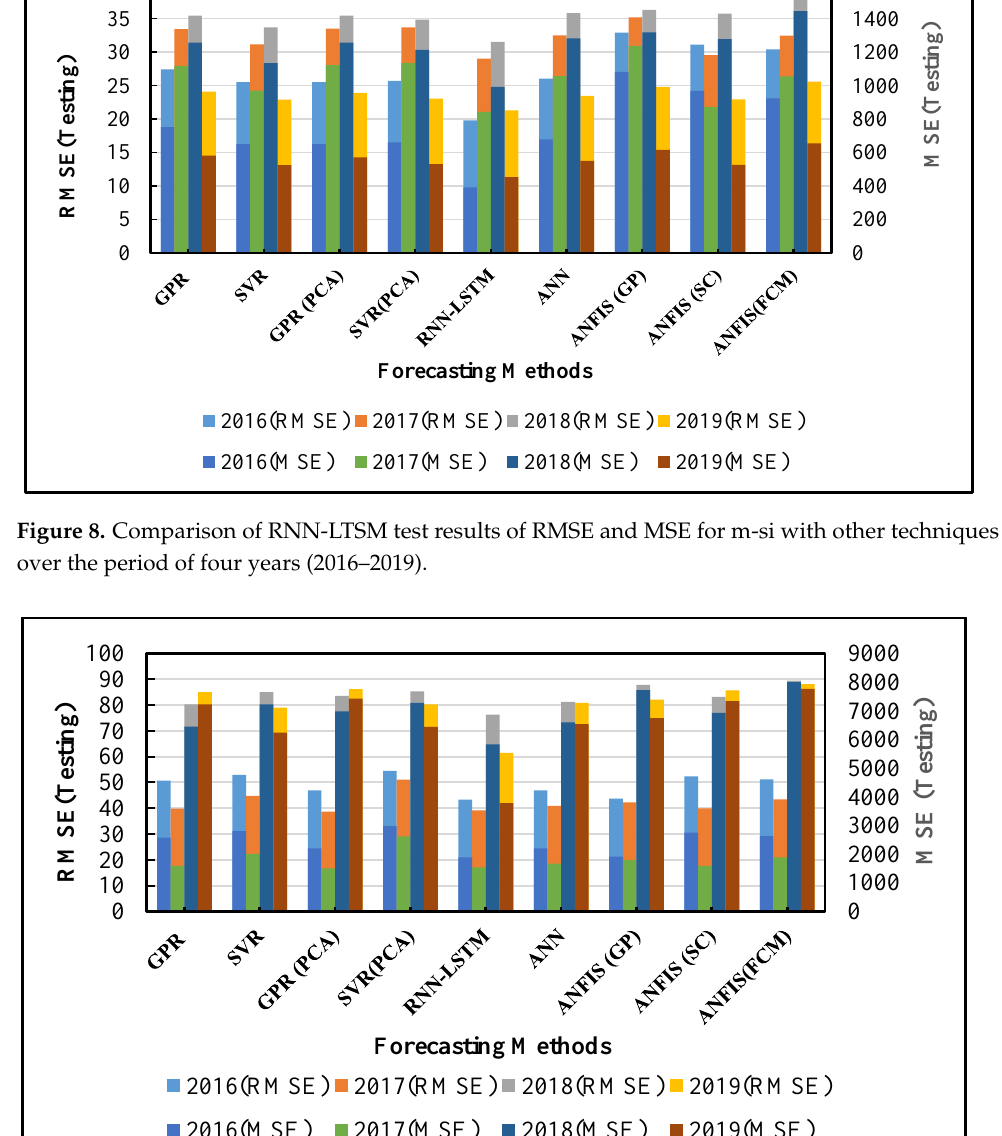
Figure 9. Comparison of RNN-LTSM test results of RMSE and MSE for a-si with other techniques over the period of four year (2016–2019).